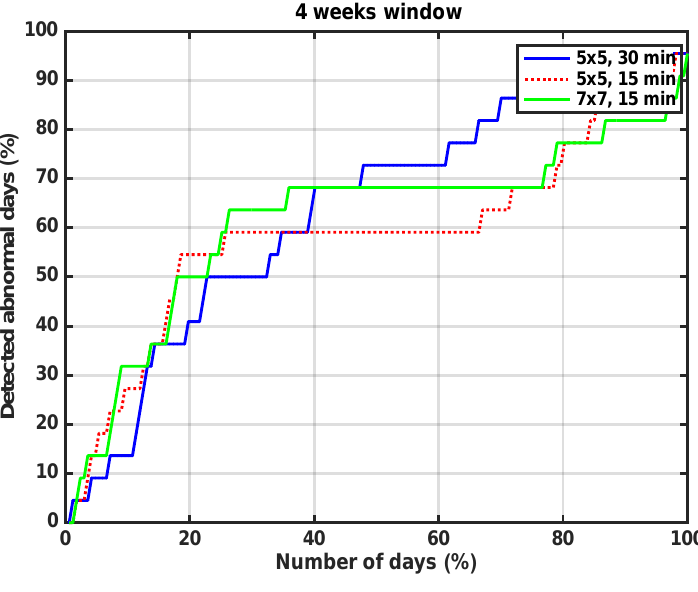
Figure 2. Abnormal day detection percentages for win = 4